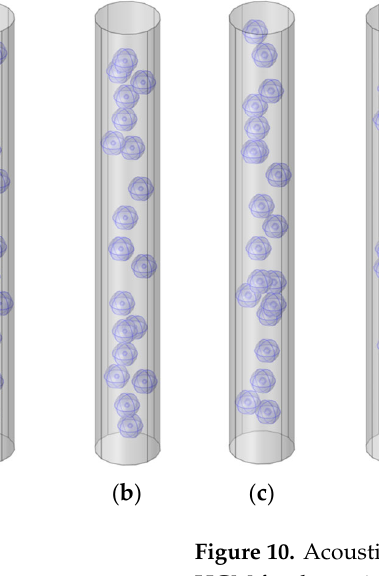
17.1025 The variation of the weighted STL along with the increase in the hollow ratio of the HGM μ h is shown in Figure 11. It could be found that the relationship between the weighted STL and the hollow ratio of the HGM was negative, particularly when the value of the μ h was larger than 50%. Along with the increase in the hollow ratio, from 10% to 90%, the weighted STL data decreased from 18.95 dB to 17.10 dB. The major reason for this phenomenon was that with the increase in the hollow ratio of the HGM μ h , the thick ‐